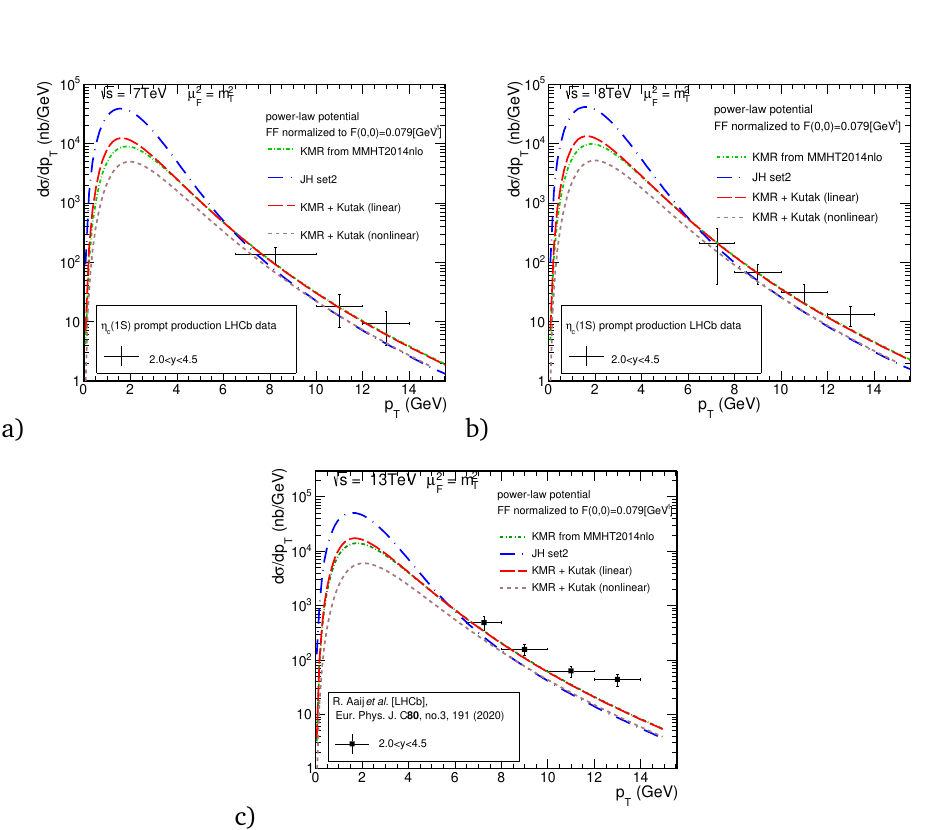
( 1 S ) production: We show the differential cross section as a func- Figure 2: Prompt η (cid:112) (cid:112) (cid:112) c s = 7TeV, b) s = 8TeV, and c) s = 13TeV. tion of transverse momentum at a) Data are from the LHCb Collaboration [ 9 ] . Figs. a) and b) are found in [ 6 ] , while Fig. c) is an update showing the now published data of Ref. [ 10 ]